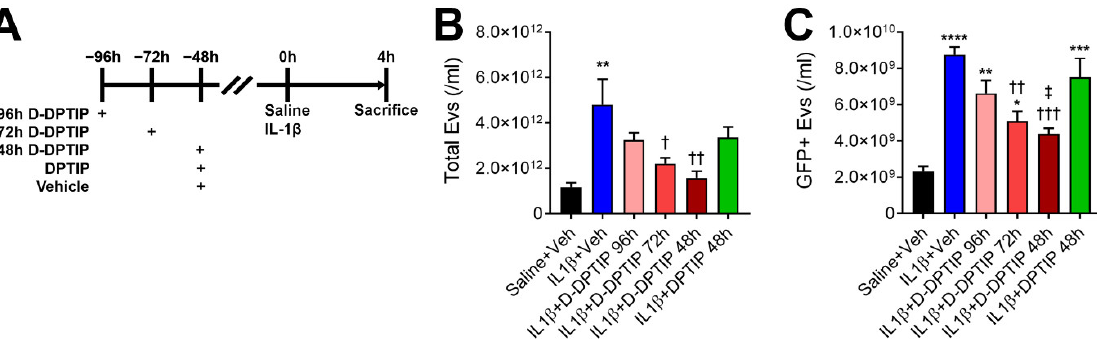
Figure 4. Oral D-DPTIP inhibits EV release into plasma in an acute brain injury model. ( A ) Experi- mental schematic. Mice were given a single oral dose of 100 mg/kg DPTIP, D-DPTIP, or vehicle at 48–96 h prior to intra-striatal IL-1 β injection. Four hours later, mice were sacrificed and both total EV and GFP + EV levels in the plasma were assessed. ( B ) Quantification of total plasma EVs from intra-striatal saline + vehicle (black), intra-striatal IL-1 β + vehicle (blue), intra-striatal IL-1 β + 96 h D-DPTIP pretreatment (pink), intra-striatal IL-1 β + 72 h D-DPTIP pretreatment (red), intra-striatal IL-1 β + 48 h D-DPTIP pretreatment (dark red), and intra-striatal IL-1 β + 48 h DPTIP pretreatment (green). ( C ) Concentration of GFP + EVs released into the plasma from astrocytes in the brain from the same animals shown in B. Bars represent mean ± SEM. * p < 0.05, ** p < 0.01, *** p < 0.001,